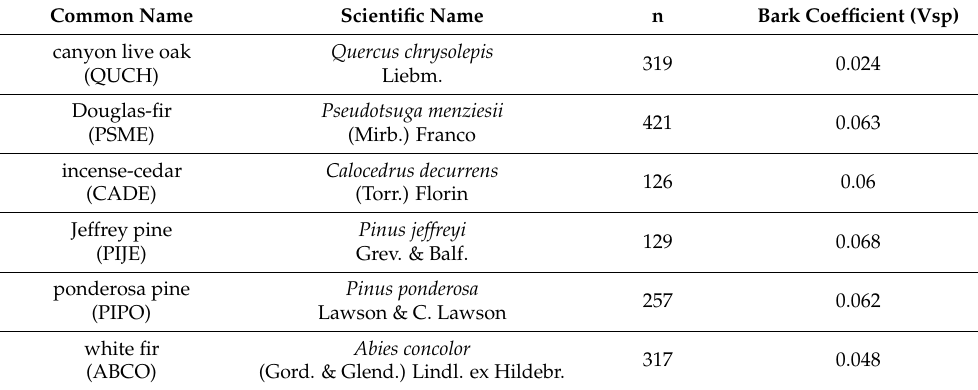
Table 1. Species common and scientific names and numbers of trees(n) and species-specific bark coefficient (Vsp) from fire-affected FIA plots used to test the post-fire delayed logistic mortality